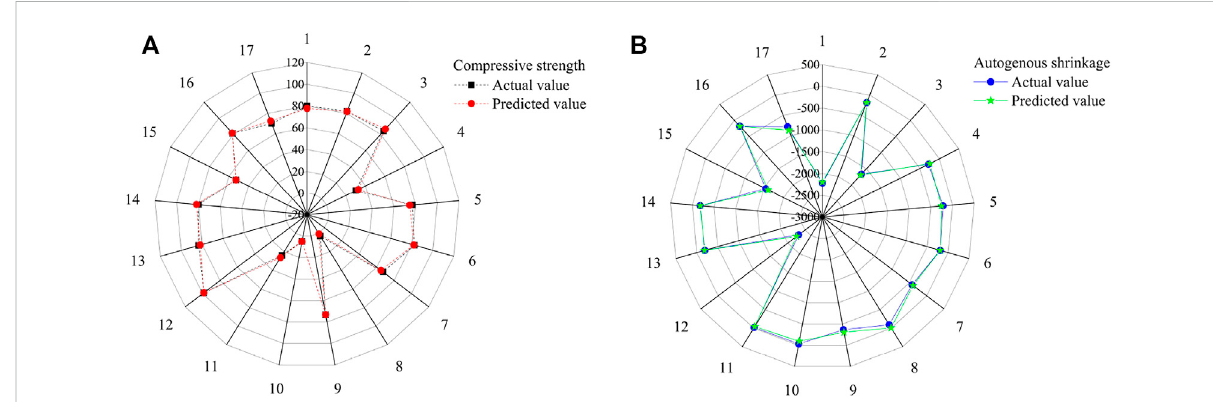
FIGURE 3 Experimental and predicted results of AASM cementitious composite specimens. (A) Compressive strength and (B) Autogenous